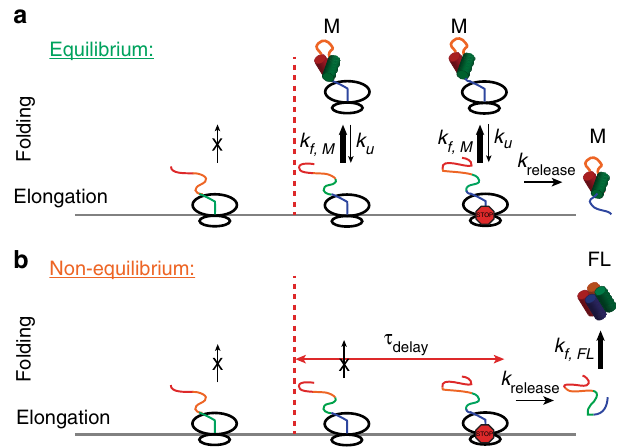
Fig. 6 Schematic of co-translational folding in and out of equilibrium. a The equilibrium scenario shows the onset of folding after reaching the minimum length predicted from stalled complexes (dashed red line). After this point the nascent chain misfolds. At the stop codon, the misfolded protein would be released from the ribosome. b Out of equilibrium, as we observe, there is a delay after reaching the length required to fold seen in equilibrium. This delay is long enough that the unfolded protein is released upon